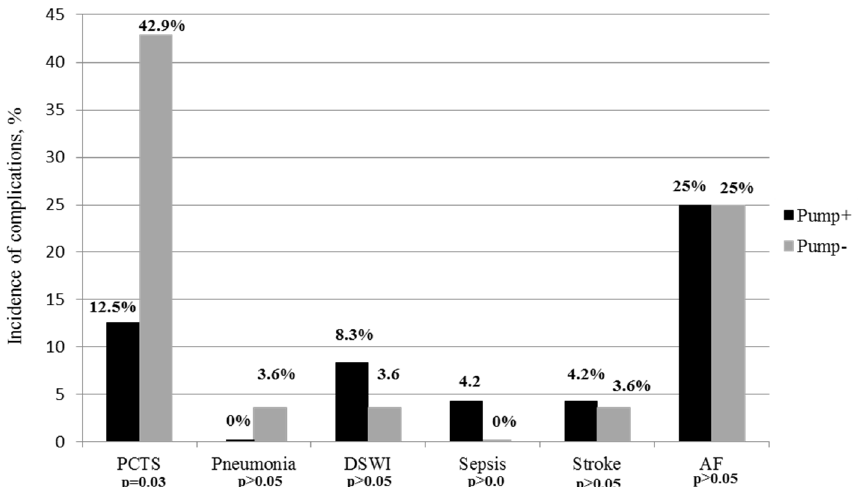
Figure 4. The incidence of complications in patients with DM2 in the early postoperative period, %. PCTS—postpericardiotomy syndrome; DSWI—deep sternal wound infection; AF-atrial fibrillations.